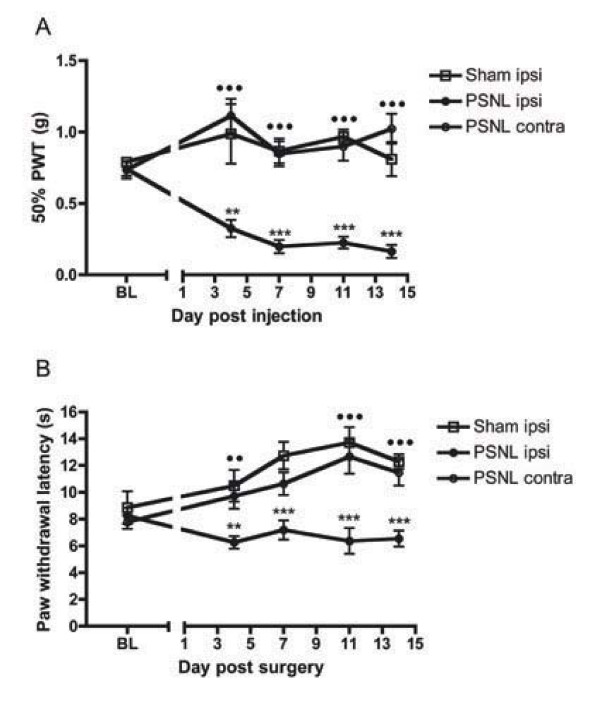
Behavioural nociception in PSNL mice. A. Development of mechanical hypersensitivity in PSNL mice. Graph depicts the changes in mechanical force required to elicit a paw withdrawal in response to a mechanical stimulus for the ipsilateral and contralateral hindpaws of PSNL mice (n = 11) and the ipsilateral hindpaws of sham mice (n = 11). 50% paw withdrawal thresholds (PWT) are expressed as mean ± S.E.M. B. Development of thermal hypersensitivity in PSNL mice. Graph depicts the time taken to elicit paw withdrawal in response to a noxious thermal stimulus for the ipsilateral and contralateral hindpaws of PSNL mice (n = 11) and the ipsilateral hindpaws of sham mice (n = 11). * denotes significant differences of ipsilateral PSNL v ipsilateral sham; denotes significant differences of PSNL ipsilateral v PSNL contralateral. 3 symbols, p < 0.001; 2 symbols, p < 0.01; 1 symbol, p < 0.05.